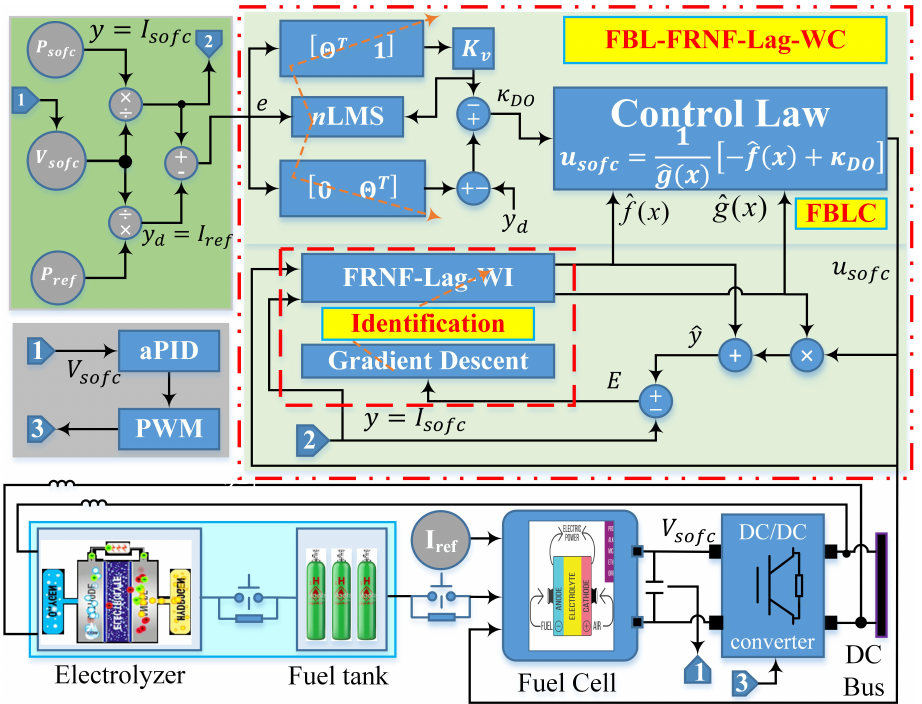
Figure 2. Closed-loop control of the solid-oxide fuel cell